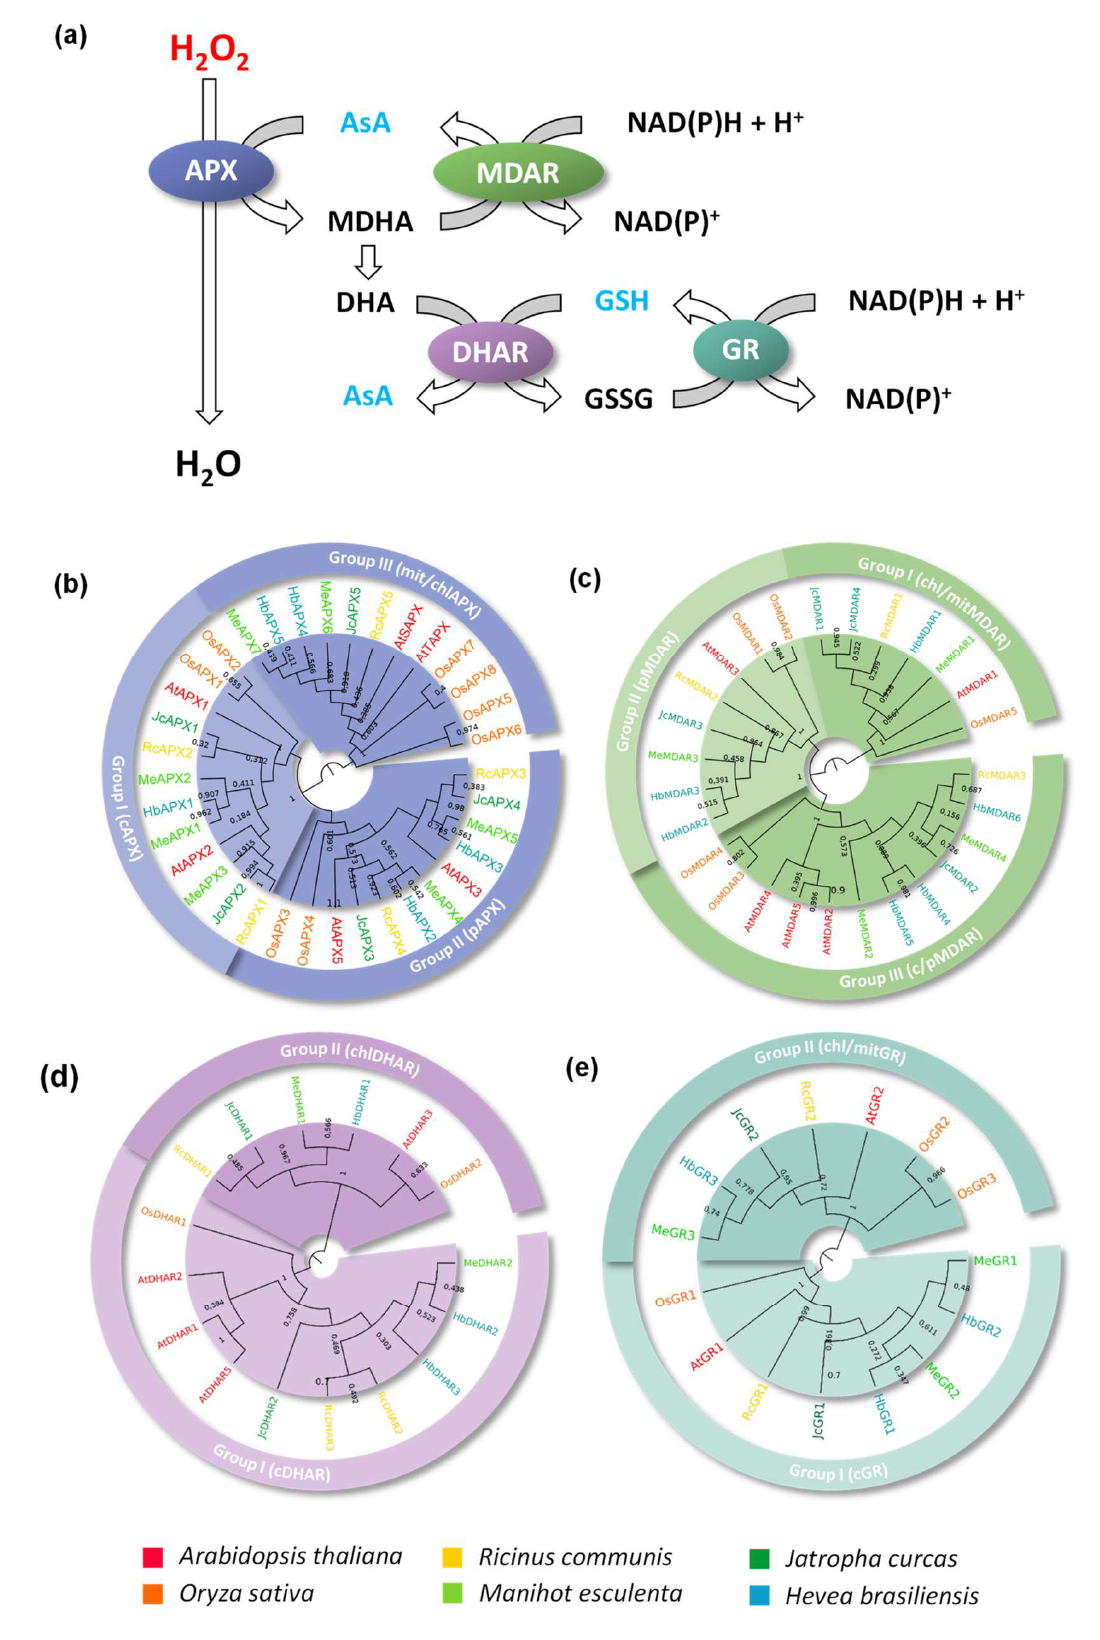
Figure 1. APX, MDAR, DHAR, and GR families in Ricinus communis (Rc), Manihot esculenta (Me), Jatropha curcas (Jc), Hevea brasiliensis (Hb), Arabidopsis thaliana (At) and Oryza sativa (Os). ( a ) Sche- matic representation of ascorbate-glutathione cycle. Phylogenetic analysis of APX ( b ), MDAR ( c ), DHAR ( d ), and GR ( e ) proteins. The phylogenetic relationships among analyzed proteins were reconstructed using the neighbor-joining method under the best model selection in MEGA 11 soft- ware with 1000 replicates of bootstrap statistics. A total of 36, 27, 16, and 15 protein sequences,